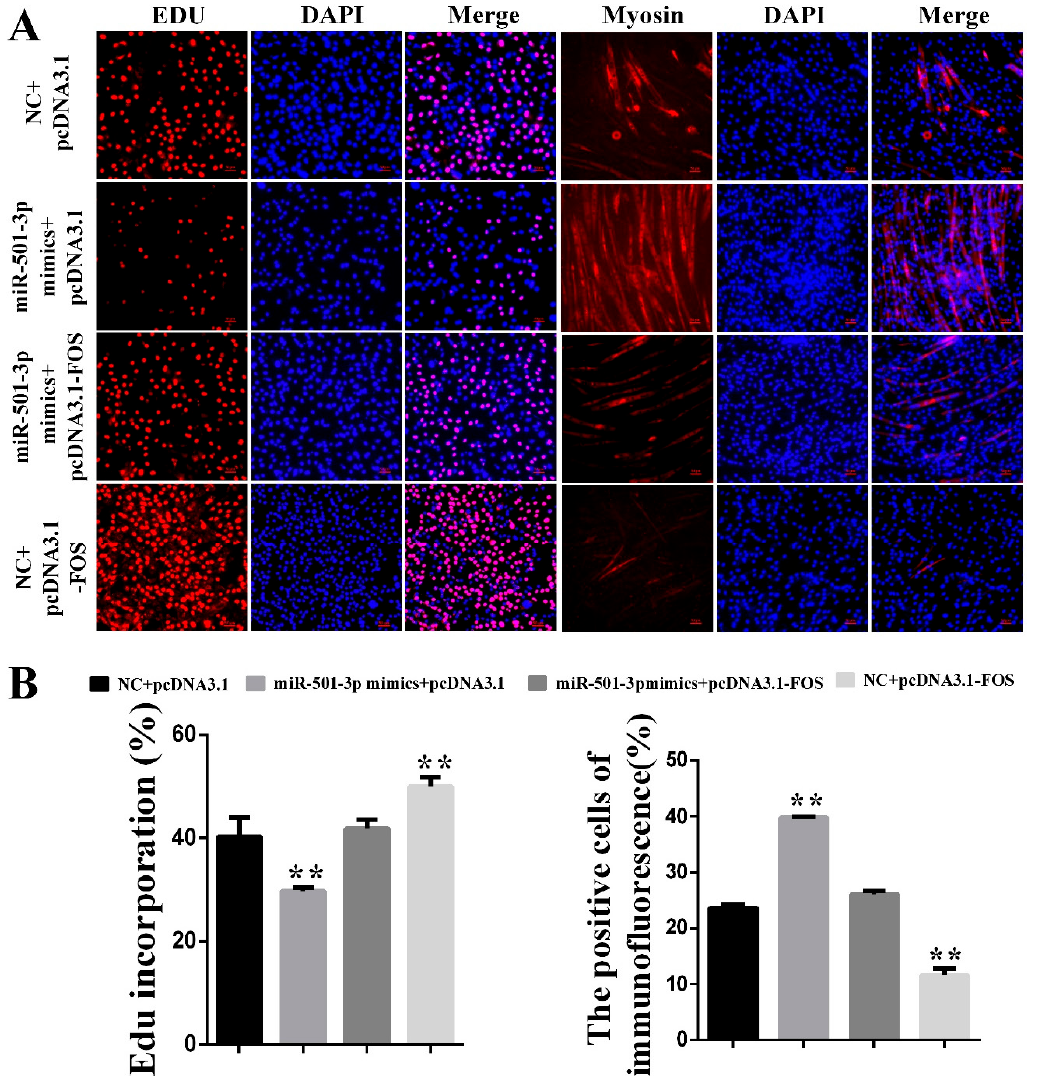
Figure 7. MiR-501-3p promotes C2C12 myogenesis by targeting FOS. ( A ) MiR-501-3p function on C2C12 proliferation and differentiation requires FOS. Representative images of the immunofluorescent staining for proliferating C2C12 and differentiated C2C12 are shown. ( B ) The quantitative data of proliferating and differentiated C2C12 number in Figure 7A. ** p ＜ 0.01. The results are presented as mean ± S.E.M. of three replicates for each group. Magnification 100×. The scale bars on the photomicrographs represent 50 μ m.